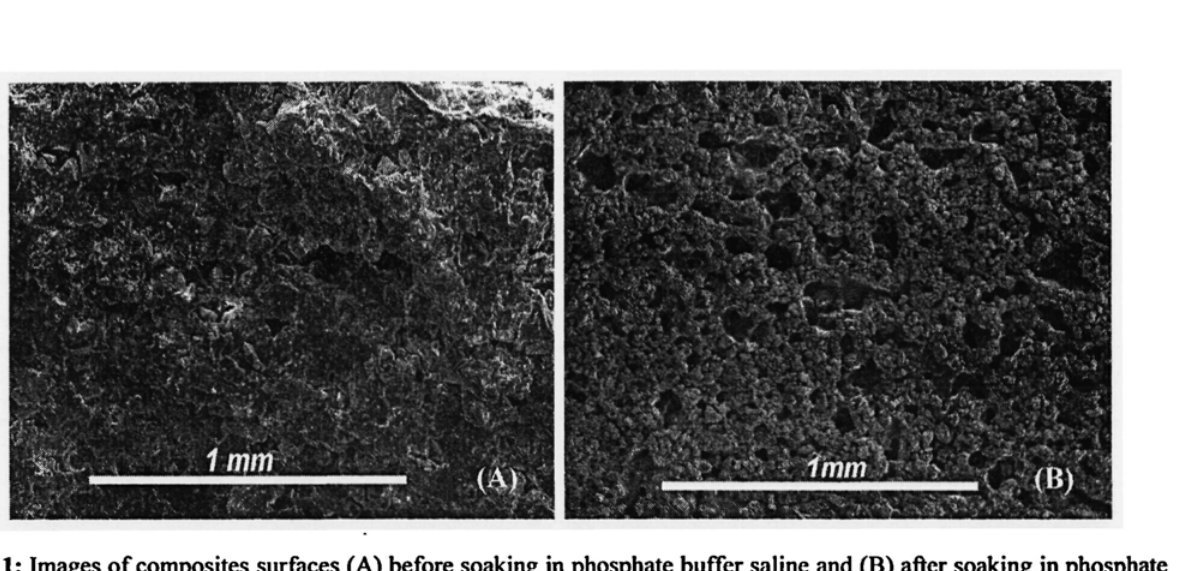
Fig. 1: Images of composites surfaces (A) before soaking in phosphate buffer saline and (B) after soaking in phosphate